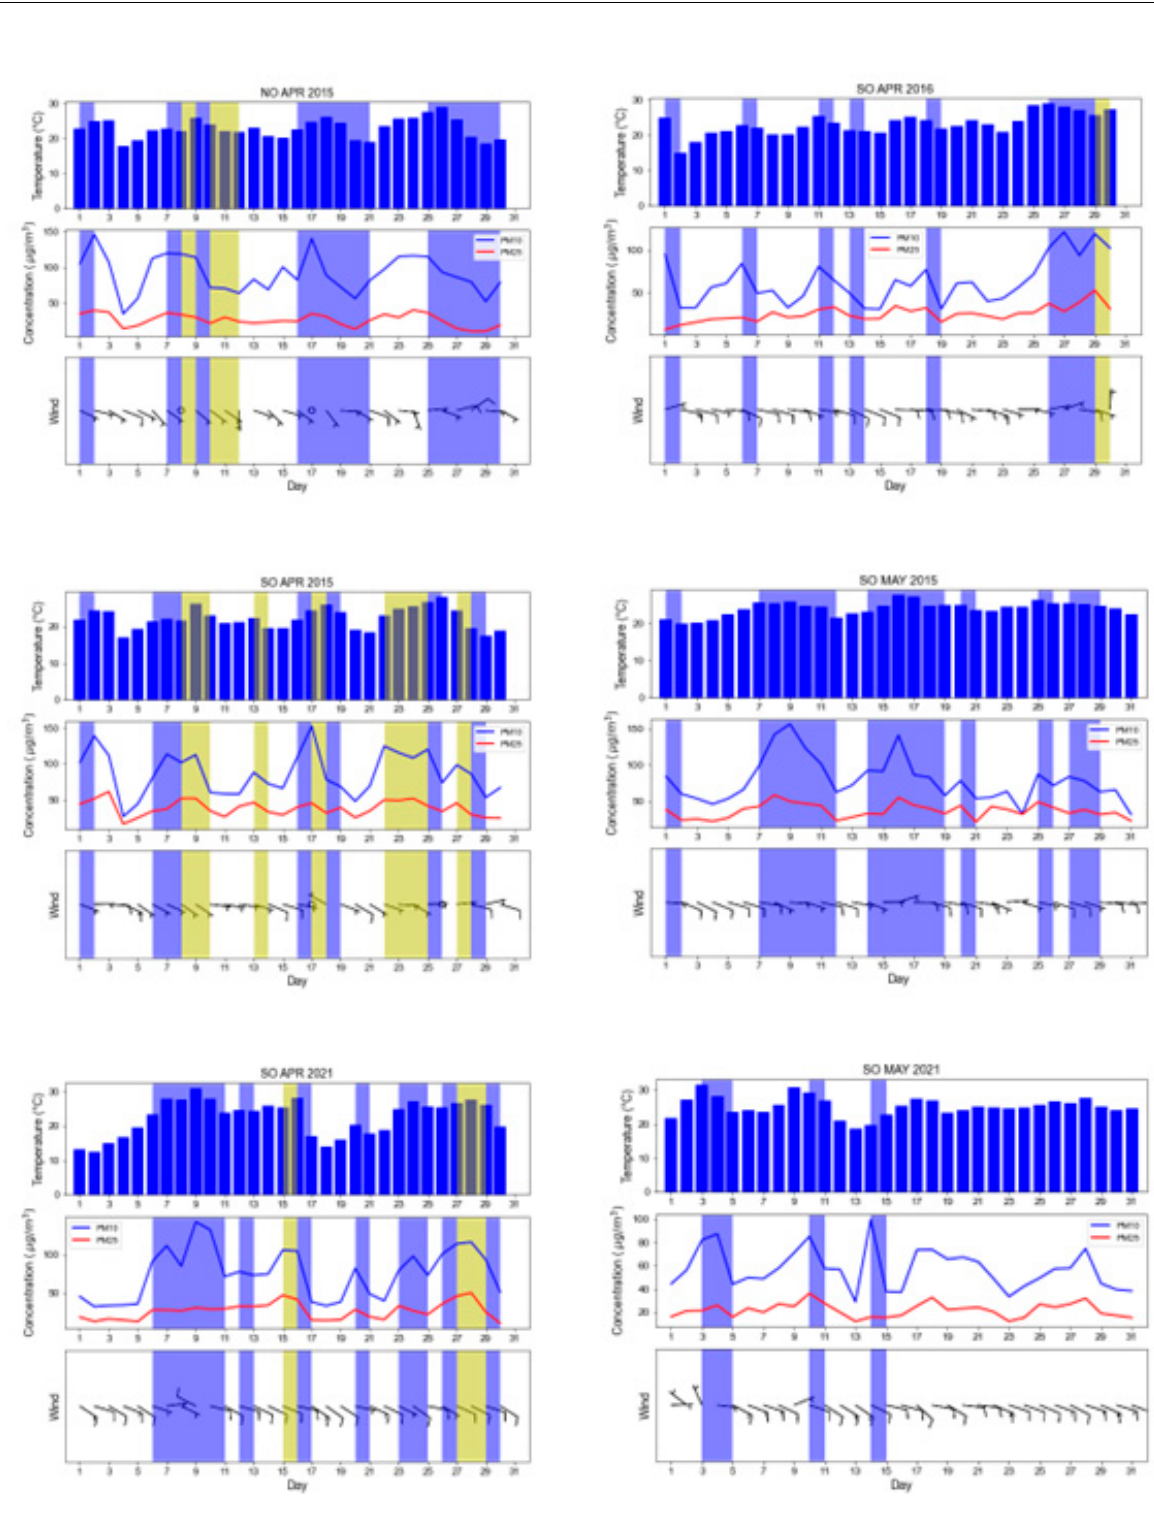
Figure A3. Meteograms for stations in Monterrey with a significant relation between wind speed and PM concentrations. Blue bars represent days over the PM 10 maximum established by the national standard for air quality. The yellow bars indicate exceeding both PM 10 and PM 2.5 maxima.